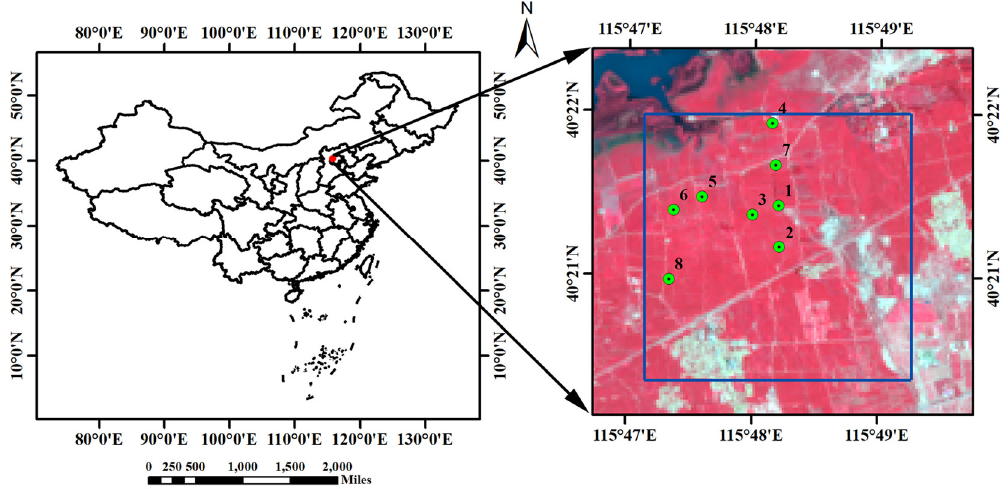
Figure 3. The location of Huailai in Hebei Province, China, and eight field sample locations overlaid on a false-color Landsat Thematic Mapper (TM) image.